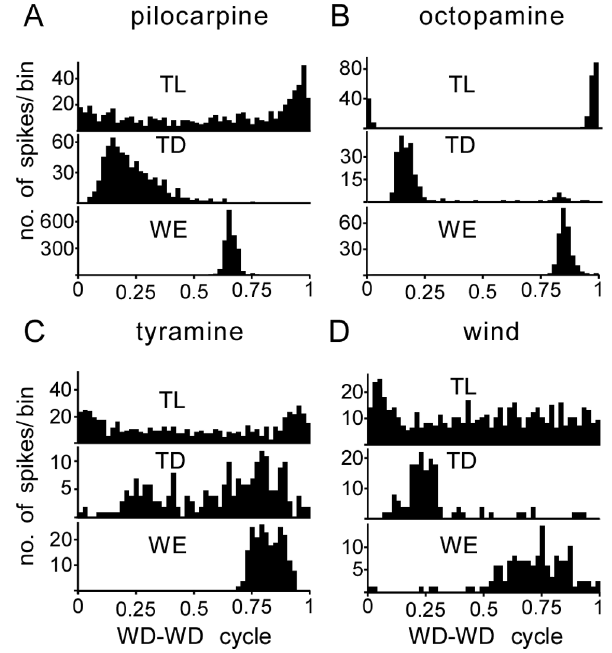
Figure 7. Charts comparing the degree of temporal coupling between different motor units for activity evoked by pilocar- pine (PC, triangles: 1 mM), octopamine (OA, squares: 100 mM) and tyramine (TA, circles: 100 mM). Temporal coupling was evaluated from the statistical dispersal for non-parametric data sets as given by the interquartile ranges, IQR, of the latencies and phases between units recorded for each animal in a group [33]: A WD-WE latency, B phase of wing elevator in wing depressor cycle (WE/WD-WD), C WD-TD latency (coupling of leg unit TD to the wing unit WD), D phase of leg unit in wing depressor cycle (TD/WD-WD). Abbreviations as in Fig. 1. Symbols give the median (of the IQRs), ticks the IQR (of this median) and asterisks significant differences between indicated groups (Mann Whitney U test for unpaired data sets *p , 0.05, **p , 0.01, ***p , 0.001).